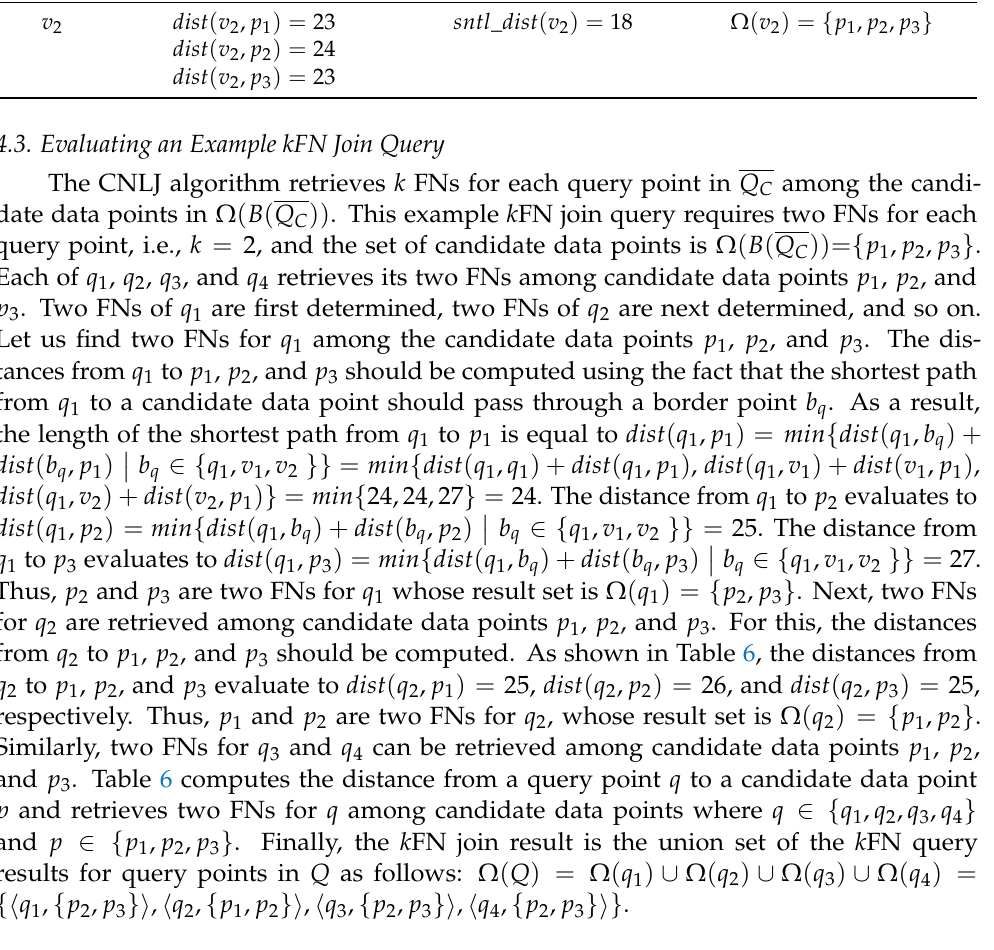
Table 6. Retrieval of two FNs for query points among candidate data